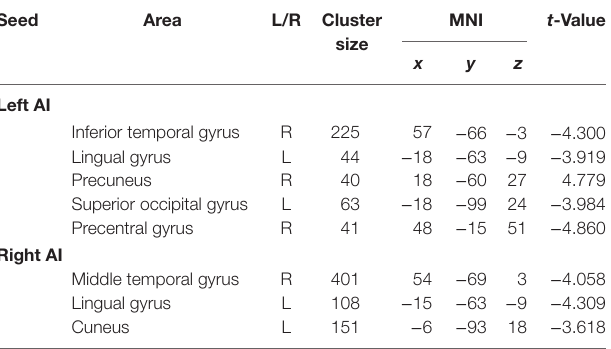
TaBle 2 | Clusters displaying significant group differences in the RSFC of AI between the ADHD and HC